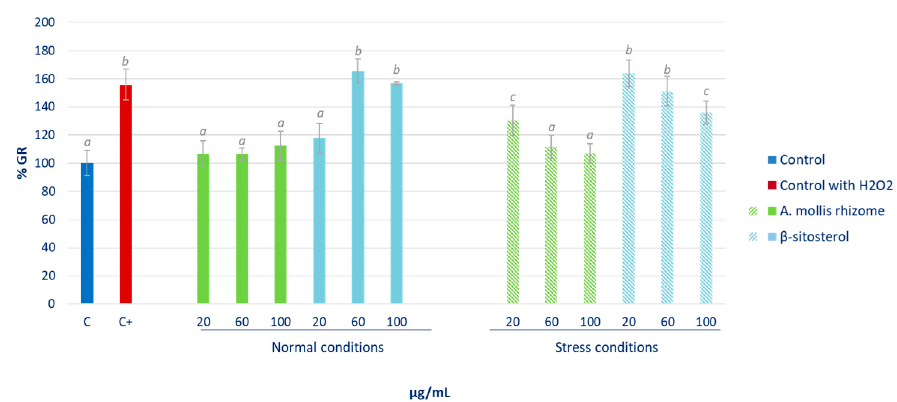
Figure 7. Effect of Acanthus rhizome extract and β -sitosterol ( µ g/mL) on glutathione reductase (GR) activity. The percentage of GR activity with respect to non-stressed control cells (C) is represented. The results are expressed as mean ± SD ( n = 3). Different letters indicate significant differences (ANOVA-Test, Bonferroni p < 0.05).